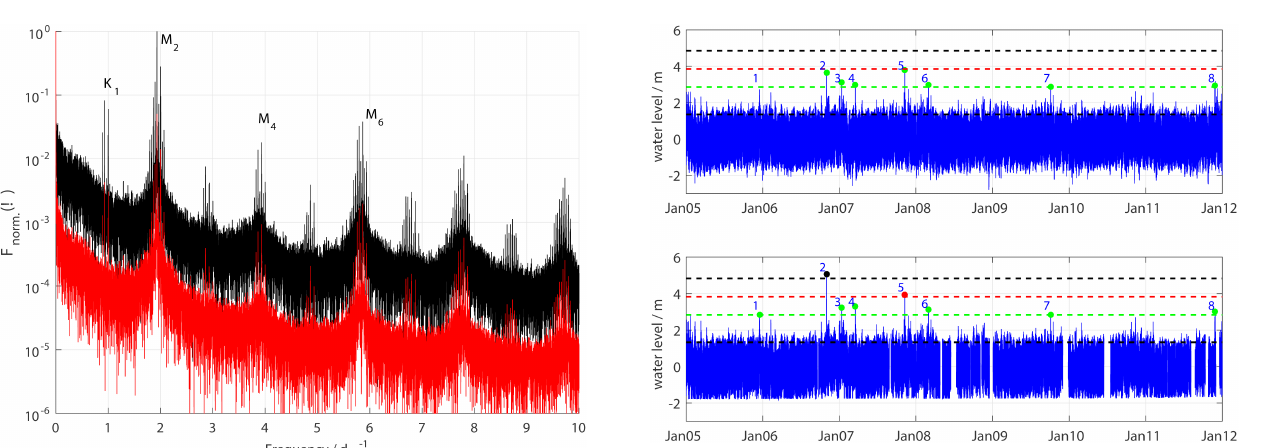
Figure 6. Fast Fourier Transformation (FFT) of the original (red) and processed (black) water level at Time Series Station Spiekeroog. K 1 : lunar diurnal constituent; M 2 : principal lunar semidiurnal constituent; M 4 and M 6 : shallow water overtide of principal lunar semi-diurnal constituent.